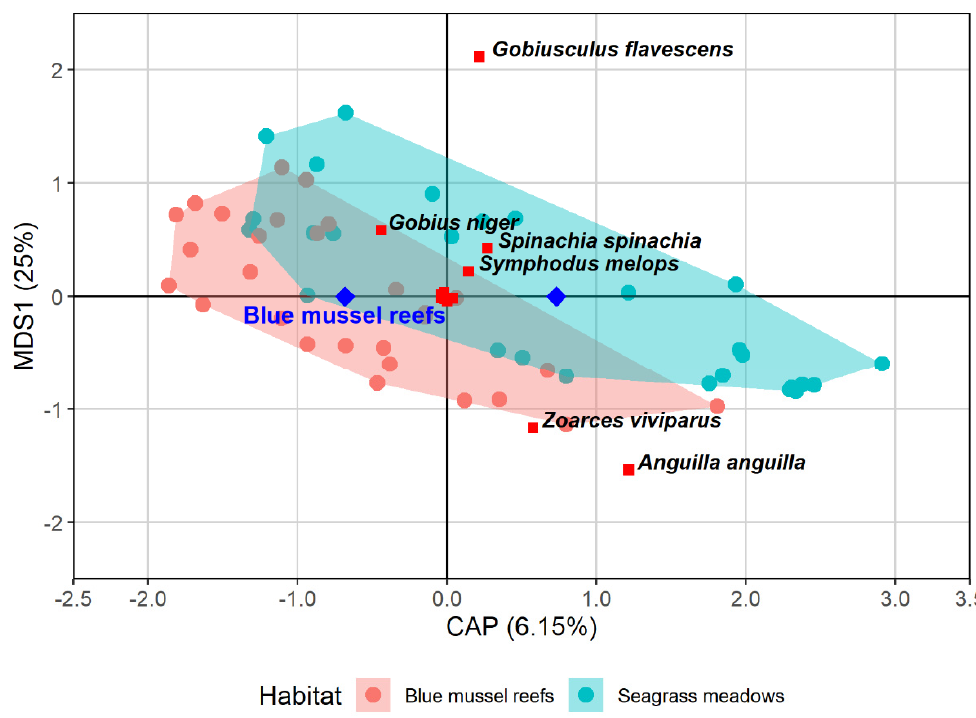
Figure 3. Distance-based redundancy analysis (db-RDA) of the abundances of fish families and species with habitat (i.e., seagrass meadow and mussel reef) as predictor. The green convex hull and point (circles) refer to the seagrass meadows (high current; field site 1), while the red convex hull and point (circles) refer to the mussel reefs (high current; field site 2) in the Western Baltic Sea (Øresund). Red square represents the species (species names are shown when the distance from the center of the axes is >0.1). Table 2. Comparison of mean fish abundances (in terms of MaxN) with associated confidence intervals (CI), recorded by underwater cameras in mussel reefs with high and low water currents in Øresund. The p values were derived from tests using a GLMM model with negative binomial distribution comparing the maximum number of fish between mussel reefs with high and low current speeds. The asterisks show the level of significance, where *** p < 0.001 and * p < 0.05.